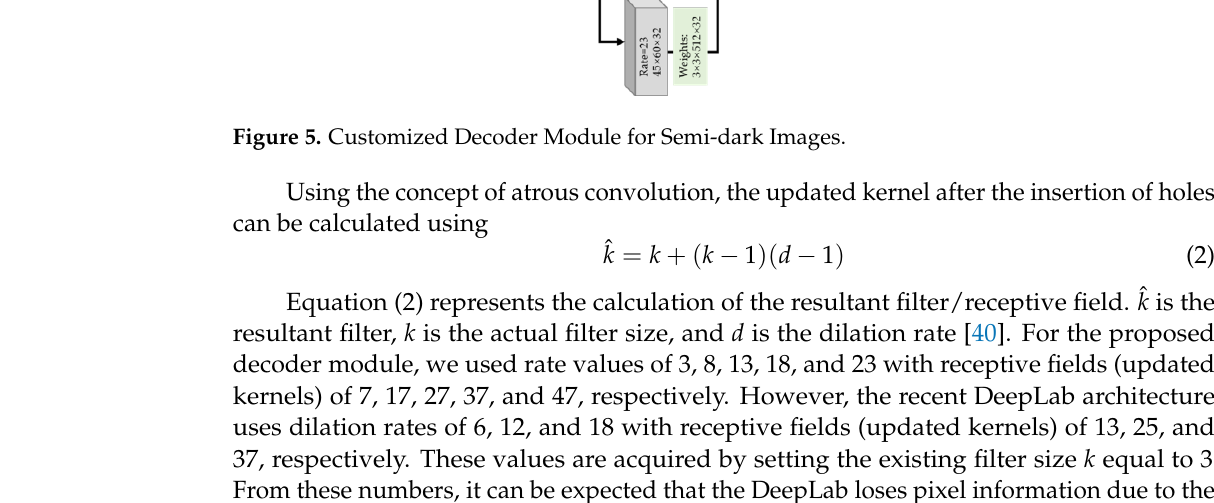
Algorithm 1: Proposed Parallel DCNN for Semi-Dark Images